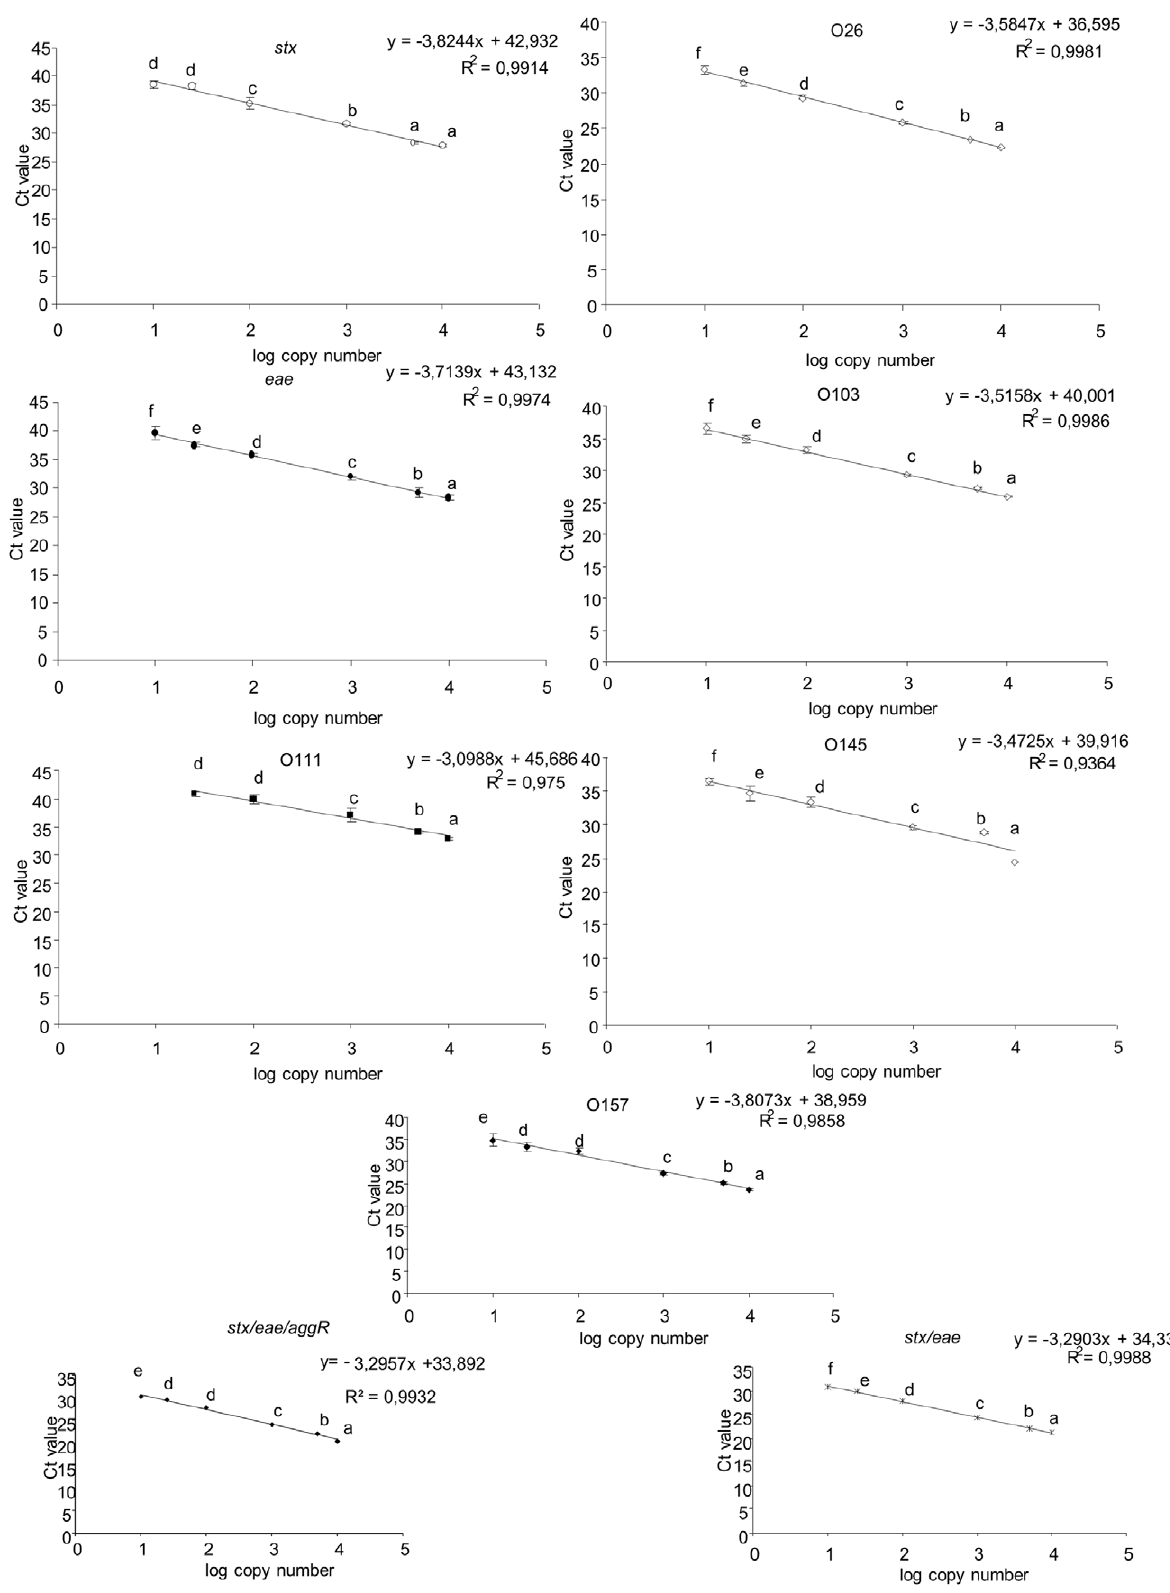
Figure 1. Dynamic range of all methods. Letters indicate significantly different values (p , 0.05).